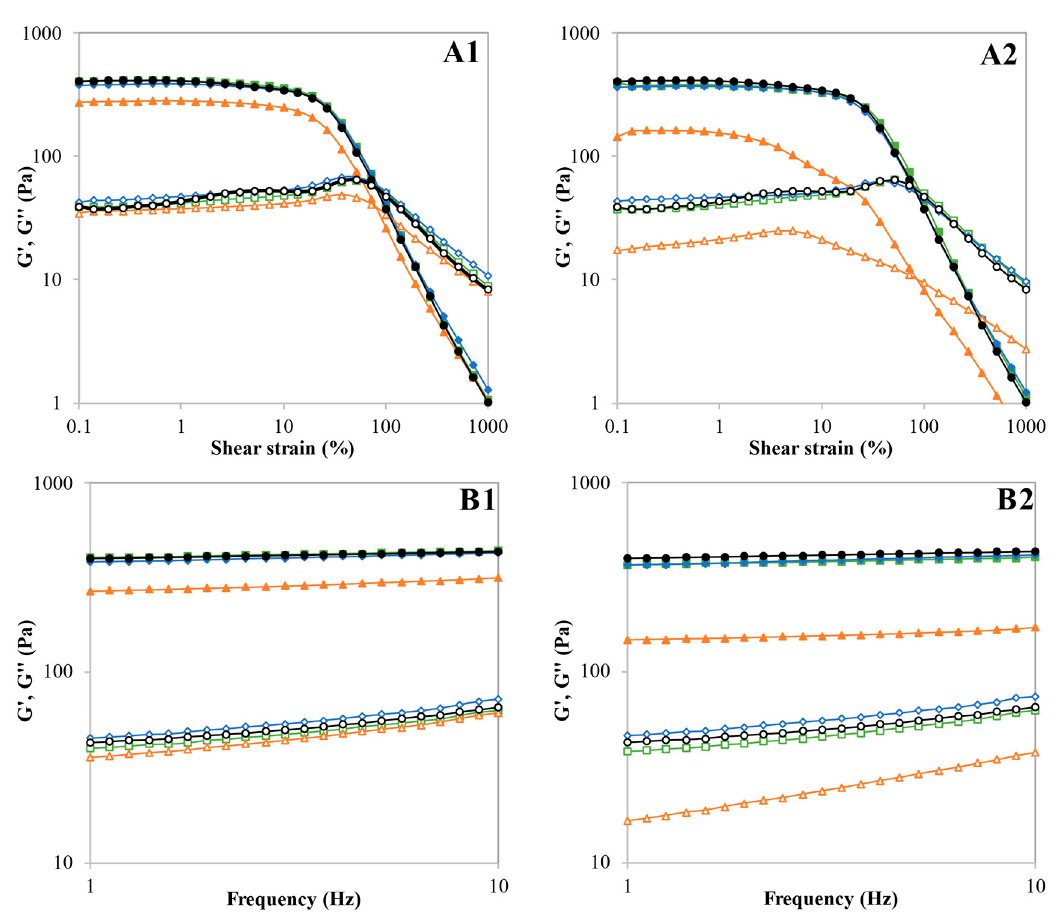
Figure 3. Strain sweeps ( A ) and frequency sweeps ( B ) of the gels made with quinoa flours obtained from untreated (native) and microwaved quinoa grains. Variable water content treatment (V) is presented in the left graphs ( 1 ) and constant water content treatment (C) in the right graphs ( 2 ). Native flour is represented in both graphs. Symbol and colour assignment: Native flour (black, ● ○ ), V-10 and C-10 (green, ◼◻ ), V-20 and C-20 (blue, ◆◇ ), V-30 and C-30 (orange, ▲△ ). G ′ is represented by full symbols and G ′′ by empty symbols.